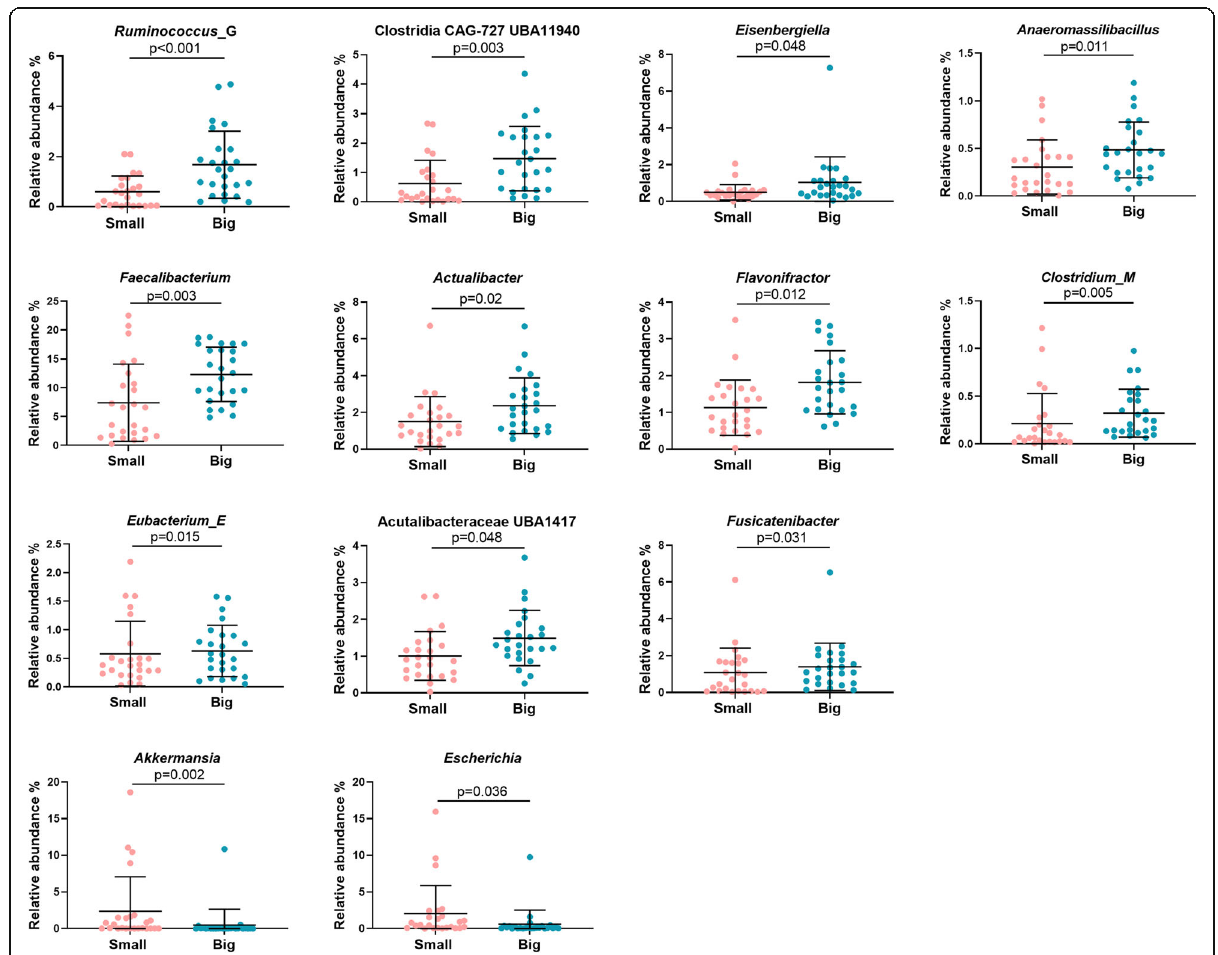
Fig. 4 Significantly different genera between Big and Small broiler chickens 1 . Differences were tested by calculating the fold change of log2- transformed relative abundances of Big relative to Small. Solid lines indicate mean with SD. 1 not all genera are referred to in the